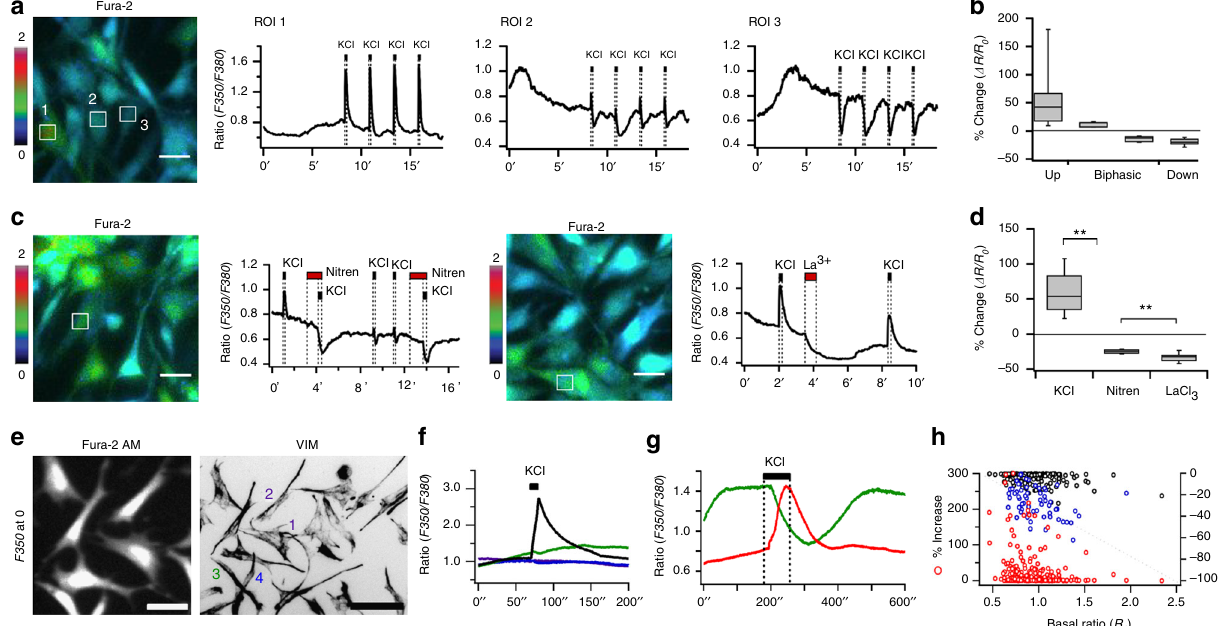
Fig. 3 Heterogeneous Ca 2 + responses in cultured mesenchymal cells. a, b Three types of Ca 2 + responses upon 100 mM KCl stimuli in H&H 35 single mesenchymal cells: KCl-induced Ca 2 + increase (ROI 1, n = 24/73), biphasic Ca 2 + response (ROI 2, n = 7/73), KCl-induced Ca 2 + decrease (ROI 3, n = 42/ 73). Rectangles denote regions of interest (ROI) for quanti fi cation. AM-Fura-2 dyes were used to measure Ca 2 + level by excitation wavelength of 350 nm ( F350 ) and F380 . Scale bar, 25 μ m. ′ denotes minutes. Whisker bottom, box bottom, median line, box top, and whisker top correspond to 10, 25, 50, 75, and 90 percentile. c , d 10 μ M Nitrendipine (Nitren) or 10 μ M LaCl 3 was used to inhibit L-type VGCC ( n = 5) and CRAC channels ( n = 20), respectively. ** P < 0.01 (Wilcoxon rank test). e Mesenchymal cells were identi fi ed by vimentin staining after Ca 2 + measurements. Scale bars, 35 μ m, 110 μ m. f Fast denotes seconds. g Slow, gentle bath perfusion of KCl (indicated by the time delay between onset of KCl application and response) implies the